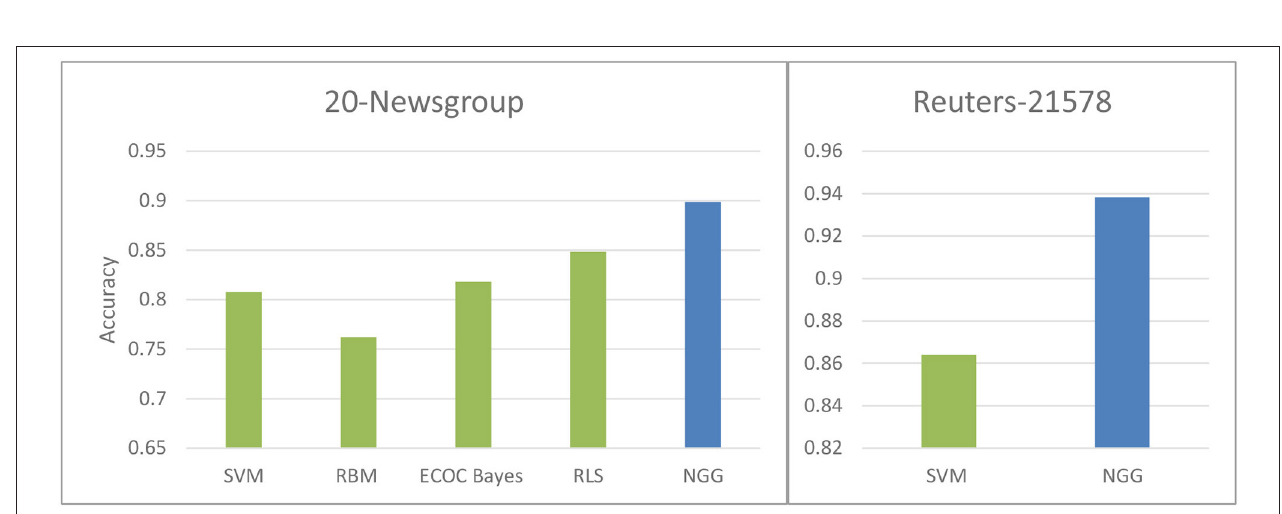
FIGURE 14 | Comparison of text classification